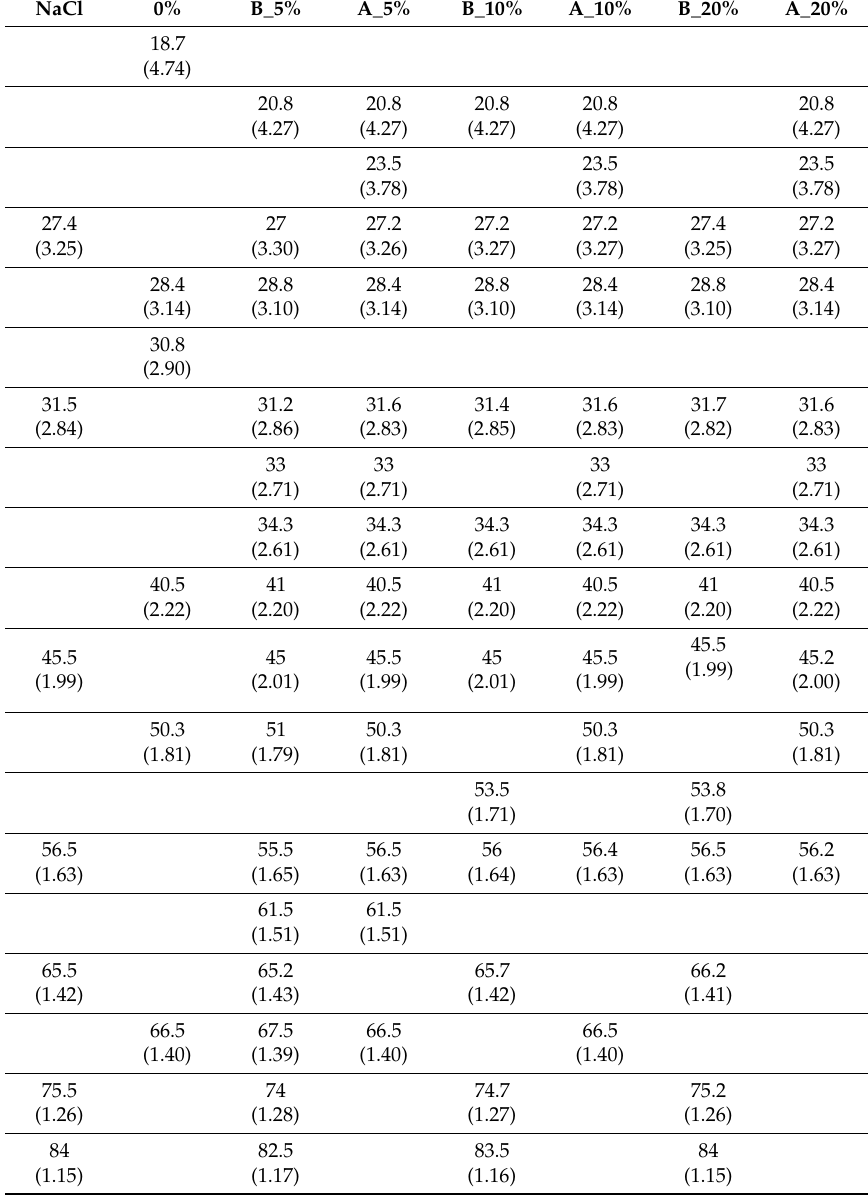
Table 5. X-ray diffraction analysis peaks for NaCl and food-waste-derived biochar with different NaCl